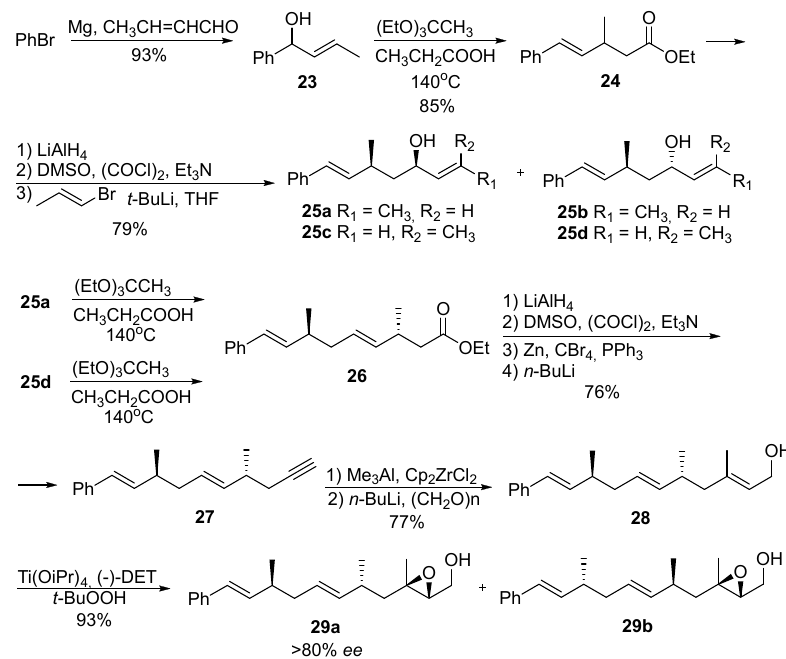
Scheme 4. Construction of asymmetric plakinic acids side chain.